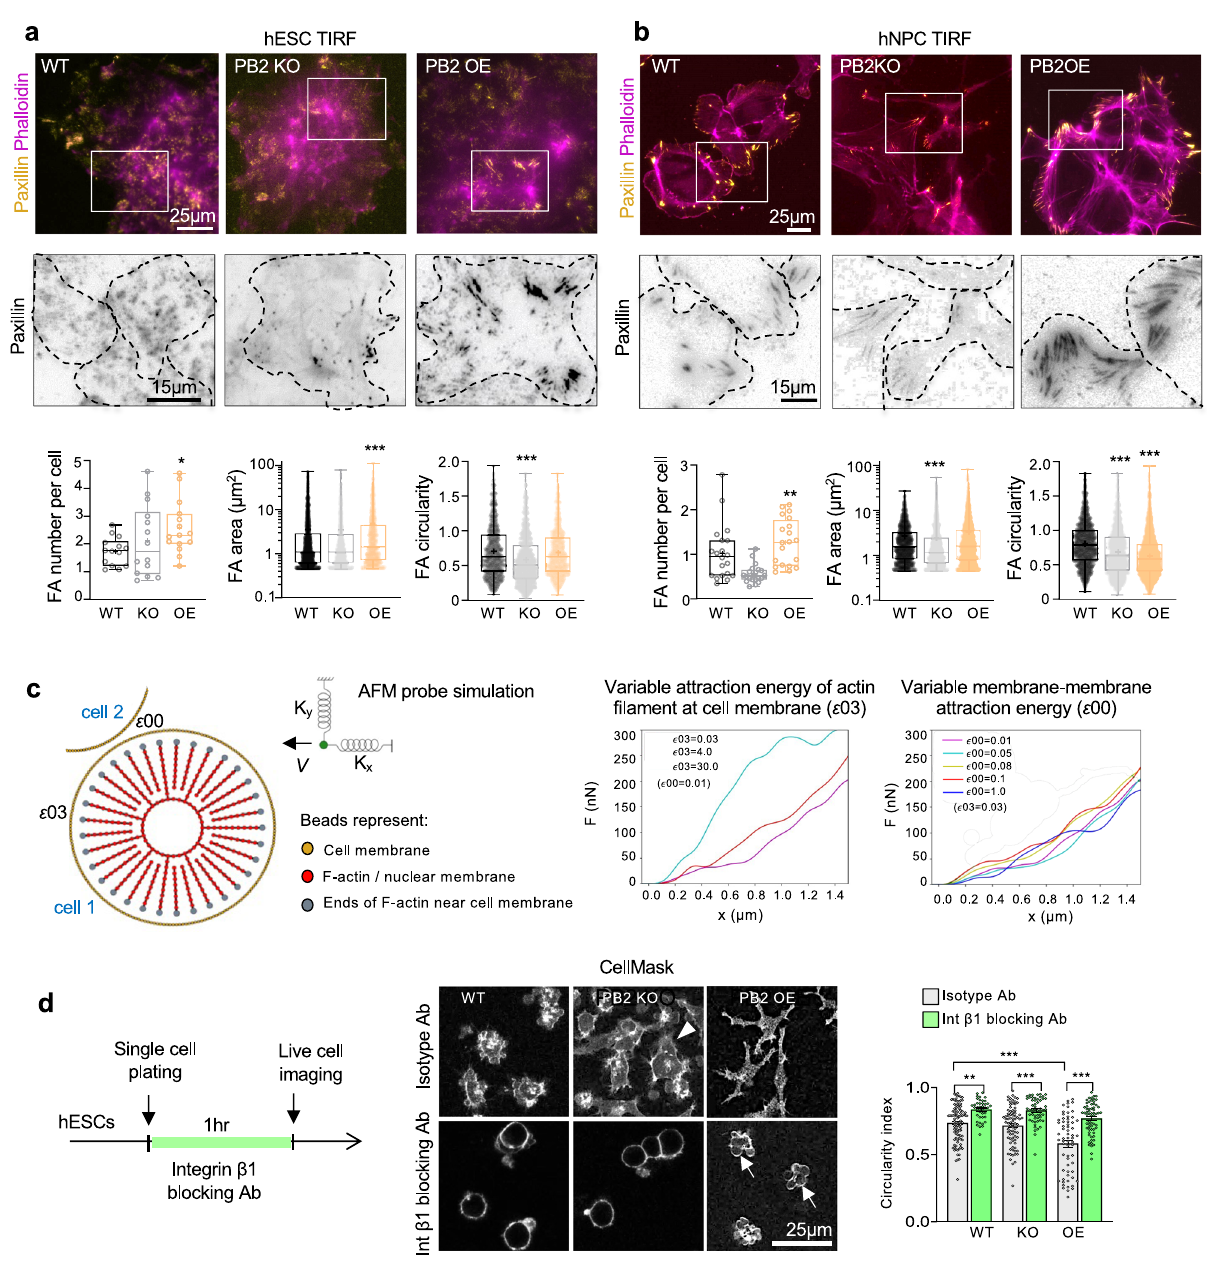
Fig. 5 Plexin-B2 in fl uences cell – matrix adhesion and controls contractility in hESC colonies. a , b TIRF microscopy images and quanti fi cation show altered number, size, and shape of focal adhesions (FAs) in PLXNB2 mutant hESC colonies ( a ) and hNPCs ( b ) compared to wild-type (WT) cells. Cells were stained for FA marker paxillin and F-actin (phalloidin). Enlarged images of boxed areas are shown below in inverted black and white, with dashed lines outlining individual cells. Box plots depict 25 – 75% quantiles, minimal and maximal values (whiskers), median (midline), and mean (cross signs). For hESCs: FA number, n = 14 – 15 cells per group. FA area, n = 2271 FAs for WT, n = 1042 for PB2 KO, and n = 978 for PB2 OE. FA circularity, n = 1042 FAs for WT, n = 1042 for PB2 KO, and n = 978 for PB2 OE. * P = 0.0397, *** P < 0.0001. For hNPCs: FA number, n = 20 cells per group. FA area and circularity, n = 1829 FAs for WT, n = 2385 for PB2 KO, and n = 4528 for PB2 OE. Kruskal – Wallis test followed by Dunn ’ s multiple comparisons test. ** P = 0.0084, *** P < 0.0001. c Molecular dynamics mathematical simulation. Left, components of simulation based on a bead-spring model. The tip of the simulated AFM probe is depicted as a green sphere, with elastic constants K x and K y in the x and y directions, respectively. Right, graphs of force as a function of distance traveled by the simulated AFM probe in two different scenarios. Left, when varying the actin-membrane attraction energy that simulates increasing contractility, the response of the force to the virtual AFM probe resembles the results of the experimental AFM data in accordance to Plexin-B2 activity (see Fig. 2). Such result is not seen when varying membrane-membrane attraction energy (right). d Left, experimental design for live-cell imaging. Middle, images of hESCs labeled with CellMask reveal distinct cell morphology when exposed to a function-blocking antibody against integrin β 1 (P5D2) or an isotype control IgG. Arrowhead points to cellular protrusion from PLXNB2 KO hESCs. Arrows point to cell membrane blebbing of PLXNB2 OE hESCs after integrin blockade. Quanti fi cation for cell roundness (circularity index) is shown on right. One-way ANOVA followed by Tukey ’ s multiple comparisons test. For isotype IgG treatment: n = 100 cells for WT, n = 80 cells for PB2 KO, and n = 63 for PB2 OE. For integrin β 1 treatment: n = 41 cells for WT, n = 54 for PB2 KO, and n = 63 cells for PB2 OE. ** P = 0.0025 and *** P < 0.0001. Data represent mean ± SEM.